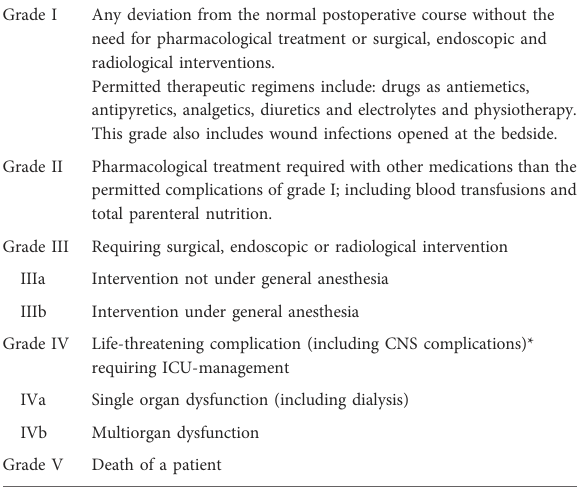
TABLE 2 Number of total complications during hospital stay (3 patients had 2 independent complications).